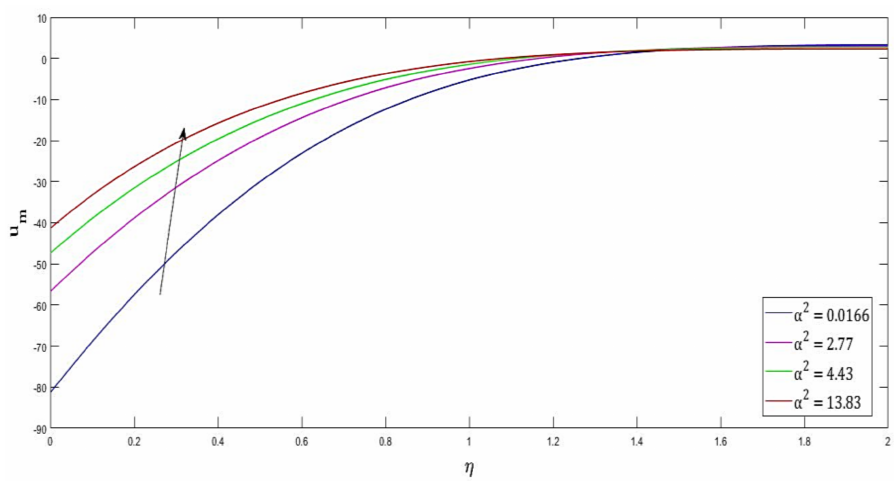
Figure 11. Variation in velocity profile with respect to Womersley number.